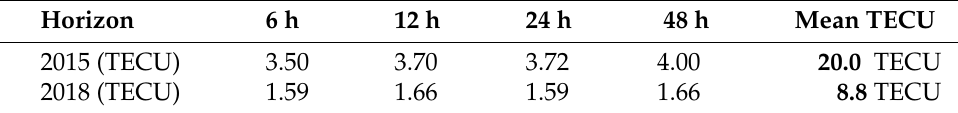
Table 5. RMSE error of the NNGIM algorithm for several horizons.